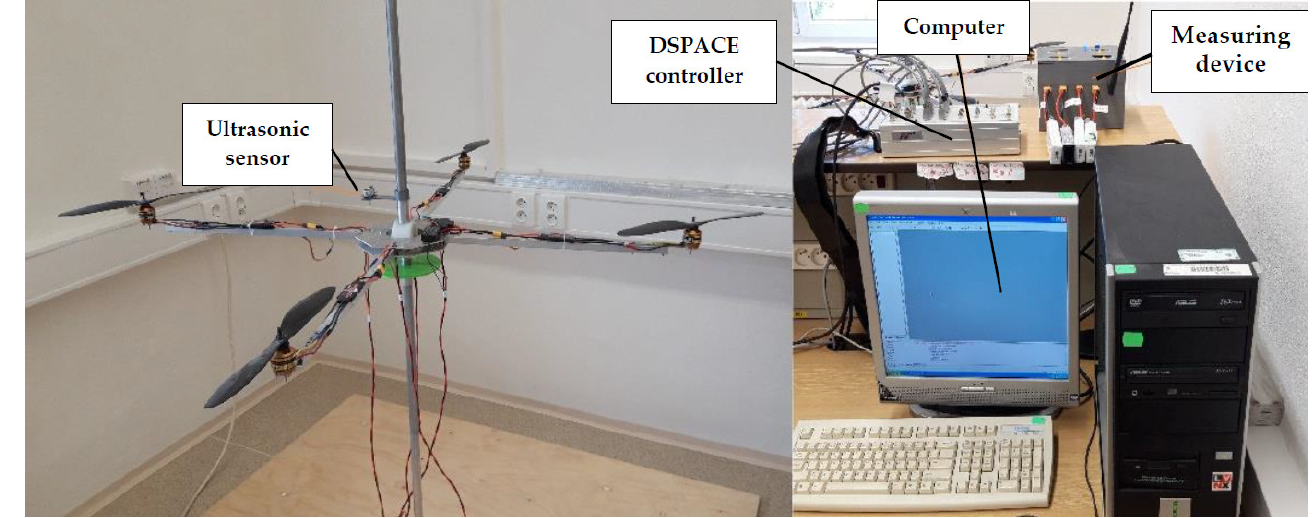
Figure 20. Test bench of regenerative braking UAVs to design control.